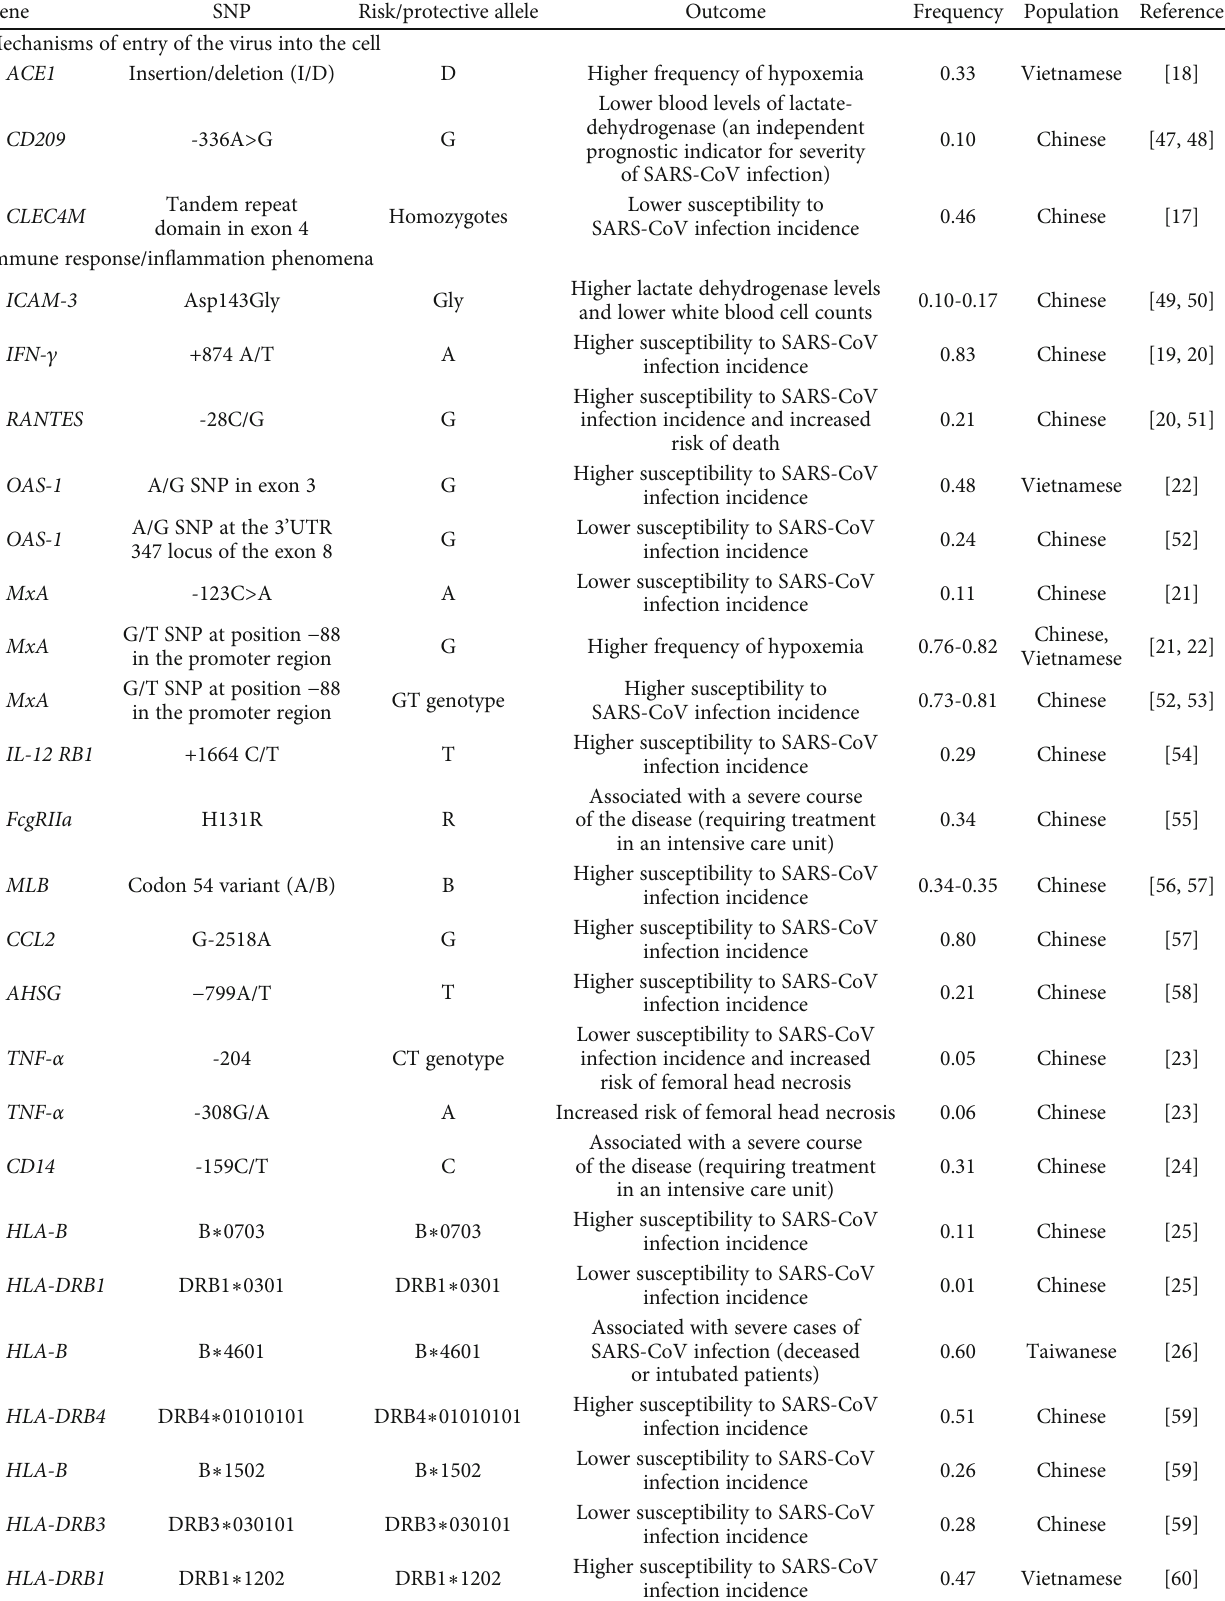
Table 1: List of relevant polymorphisms in genes implicated in the susceptibility and progression to SARS-CoV infection.